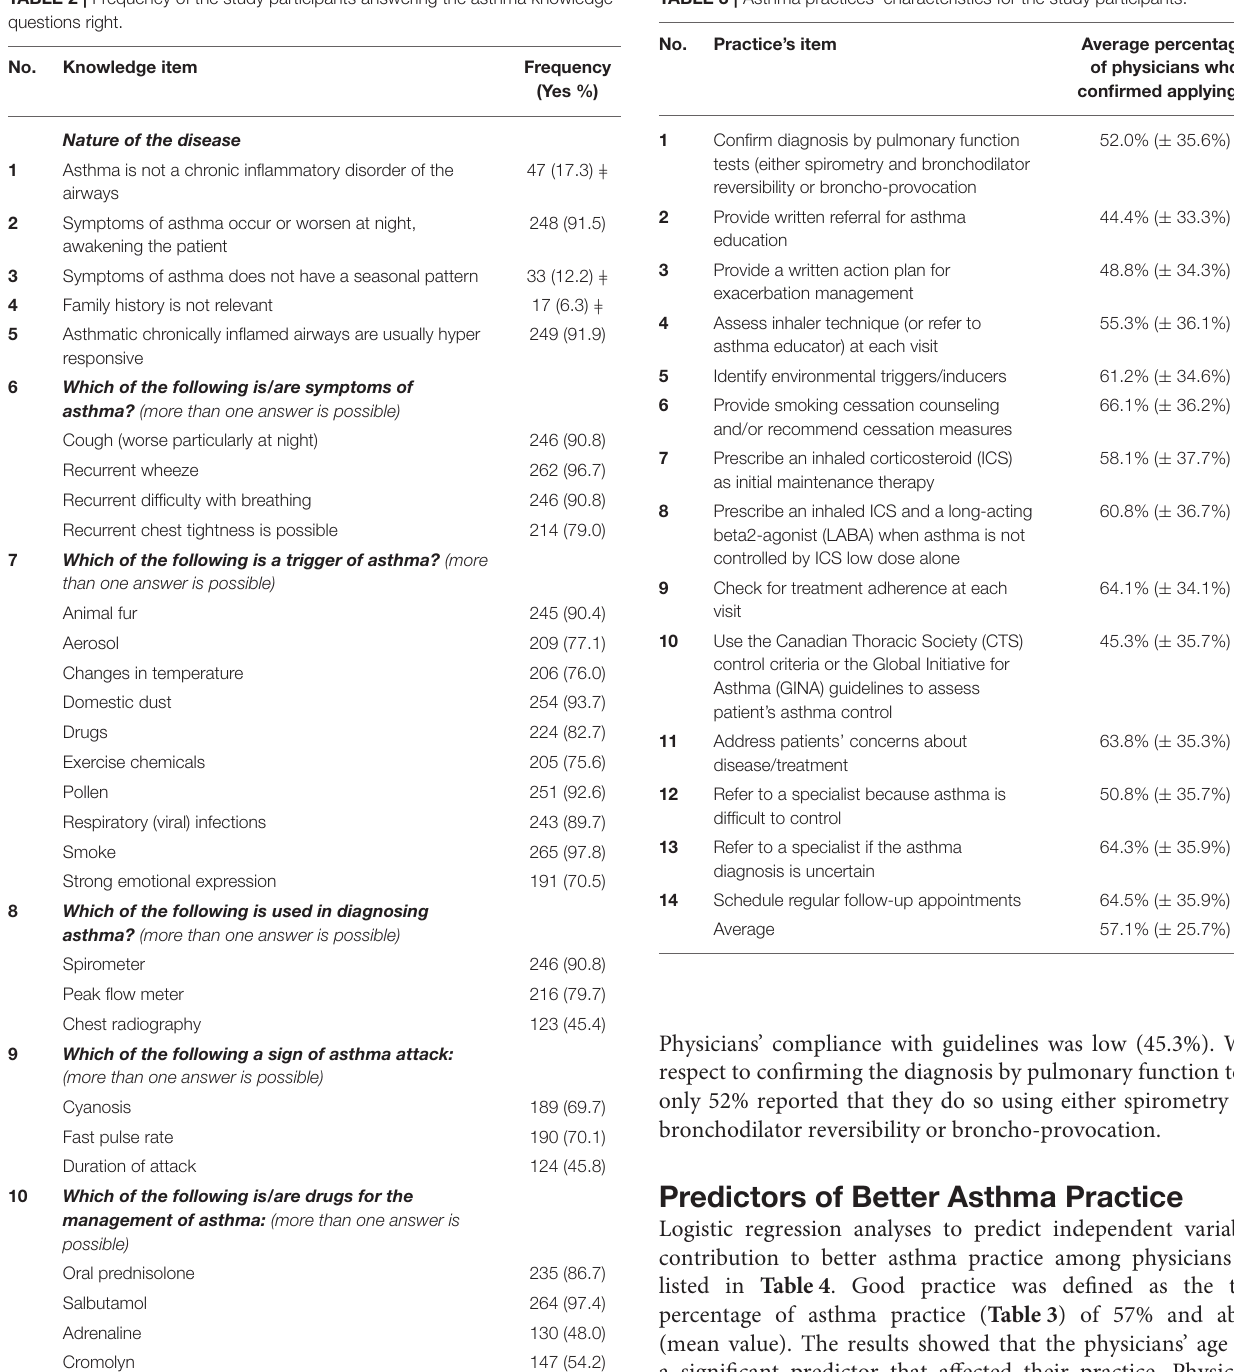
TABLE 3 | Asthma practices’ characteristics for the study